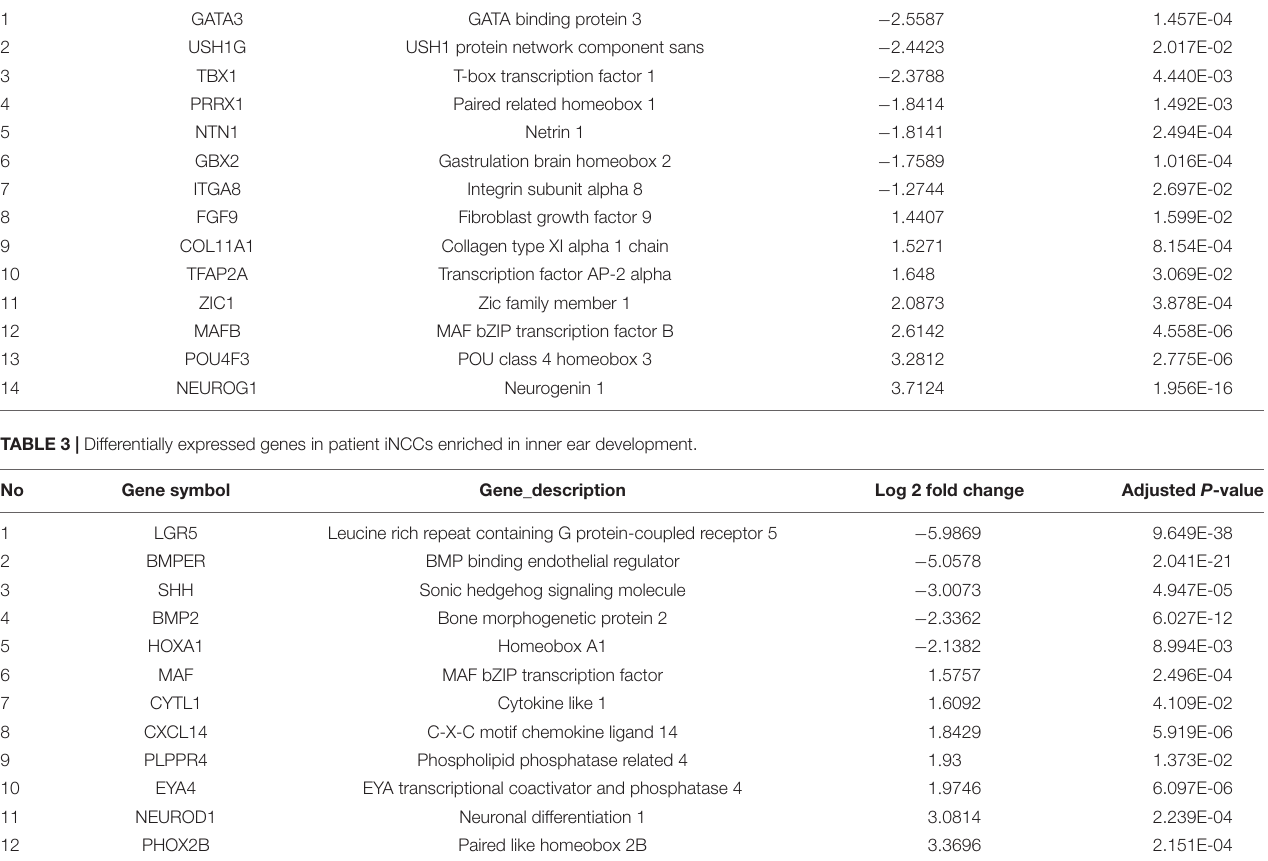
TABLE 2 | Differentially expressed genes in patient iNCCs enriched in inner ear morphogenesis. No.